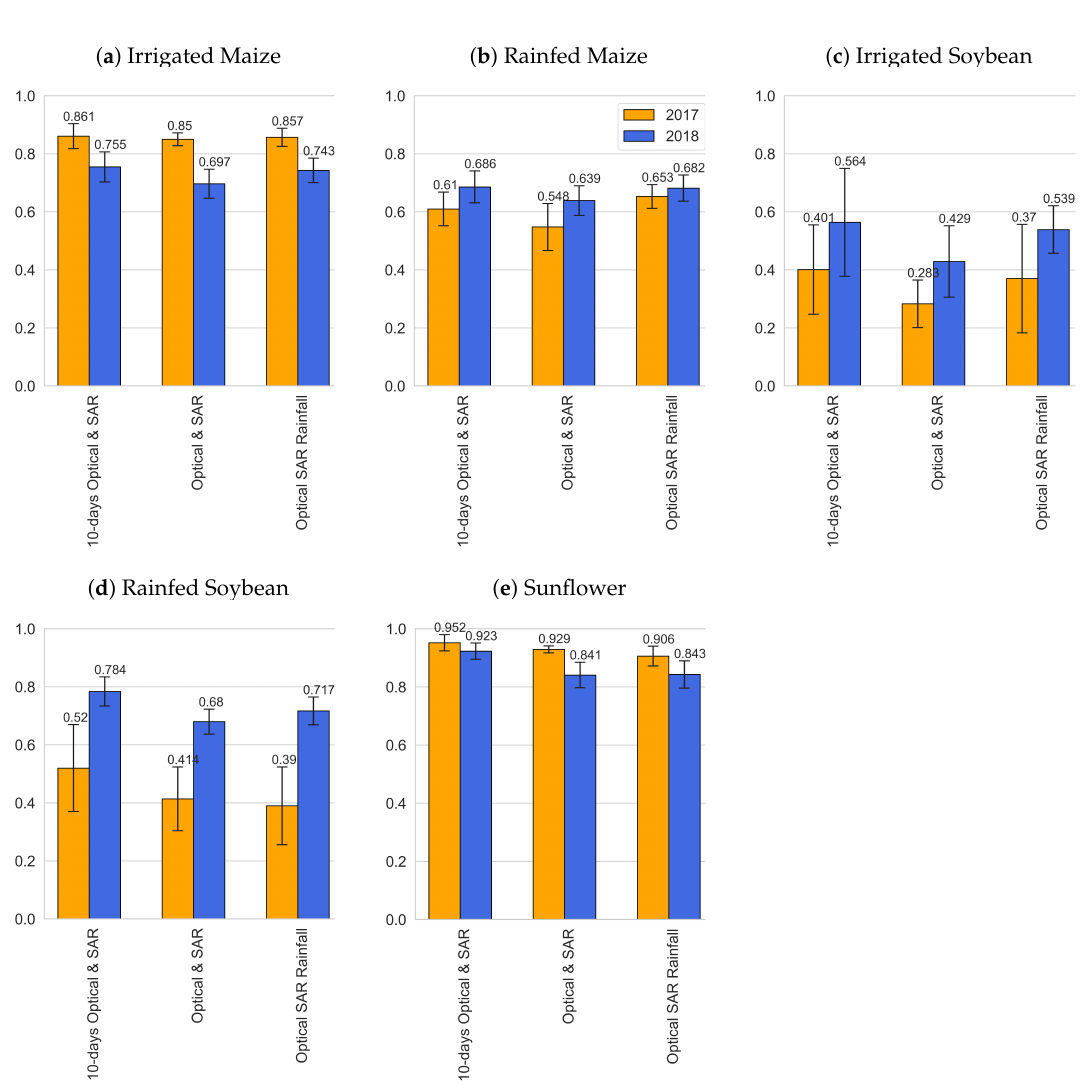
Figure 6. Fscore by class as a function of the 3 scenarios. The orange and blue bars correspond, respectively, to the years 2017 and